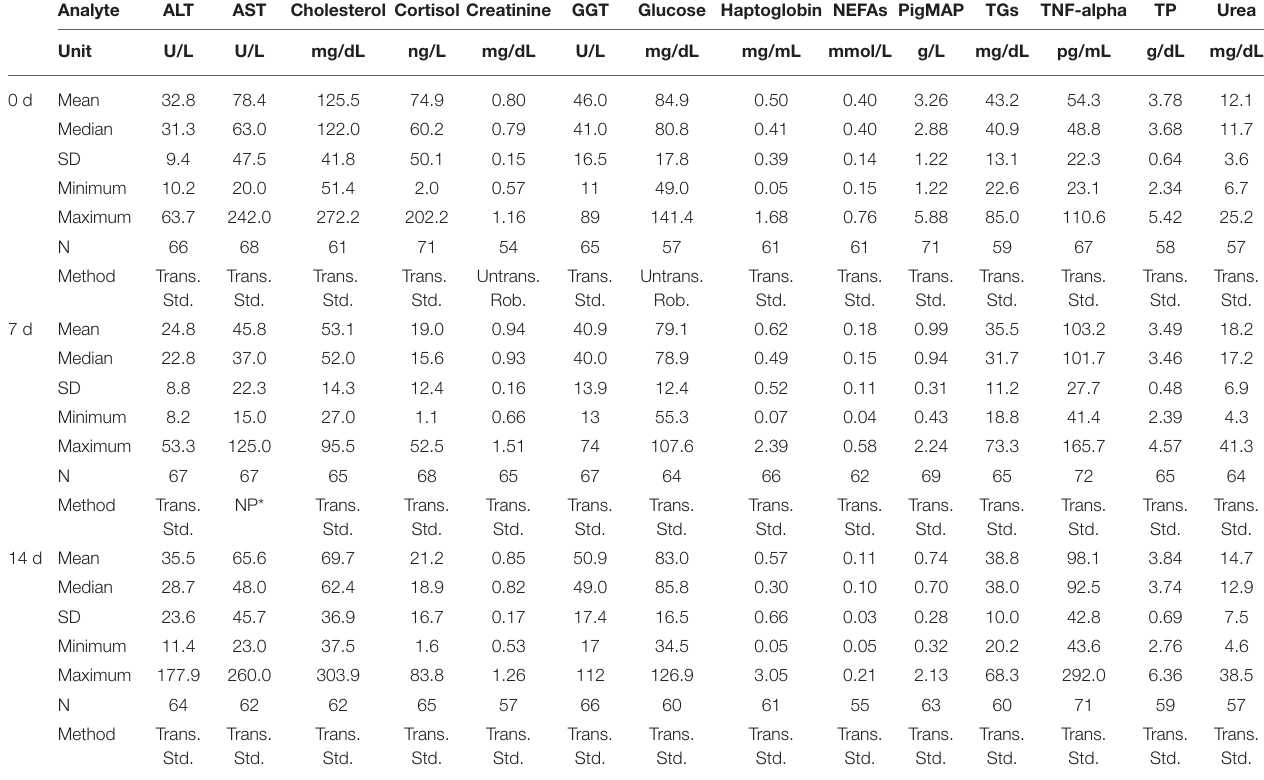
TABLE 2 | Summary of statistical values for clinical biochemistry analytes from piglets at 0, 7, and 14 days post-weaning (at 21, 28, and 35 days of age).